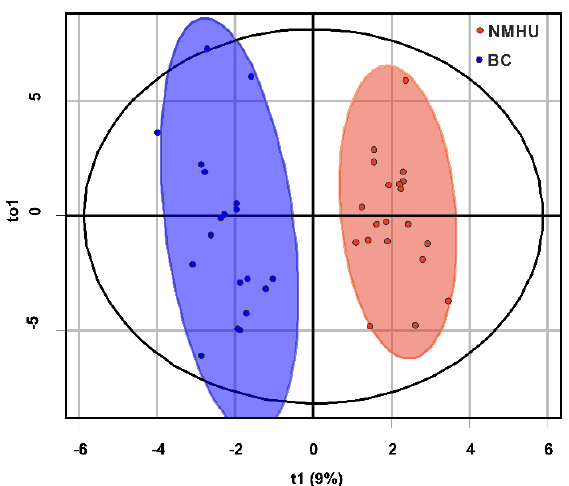
Figure 4. OPLS-DA score plot (patients with bladder cancer (blue), patients with non-malignant hematuria (red); dots represent the metabolomics profile of the urine of an individual subject).